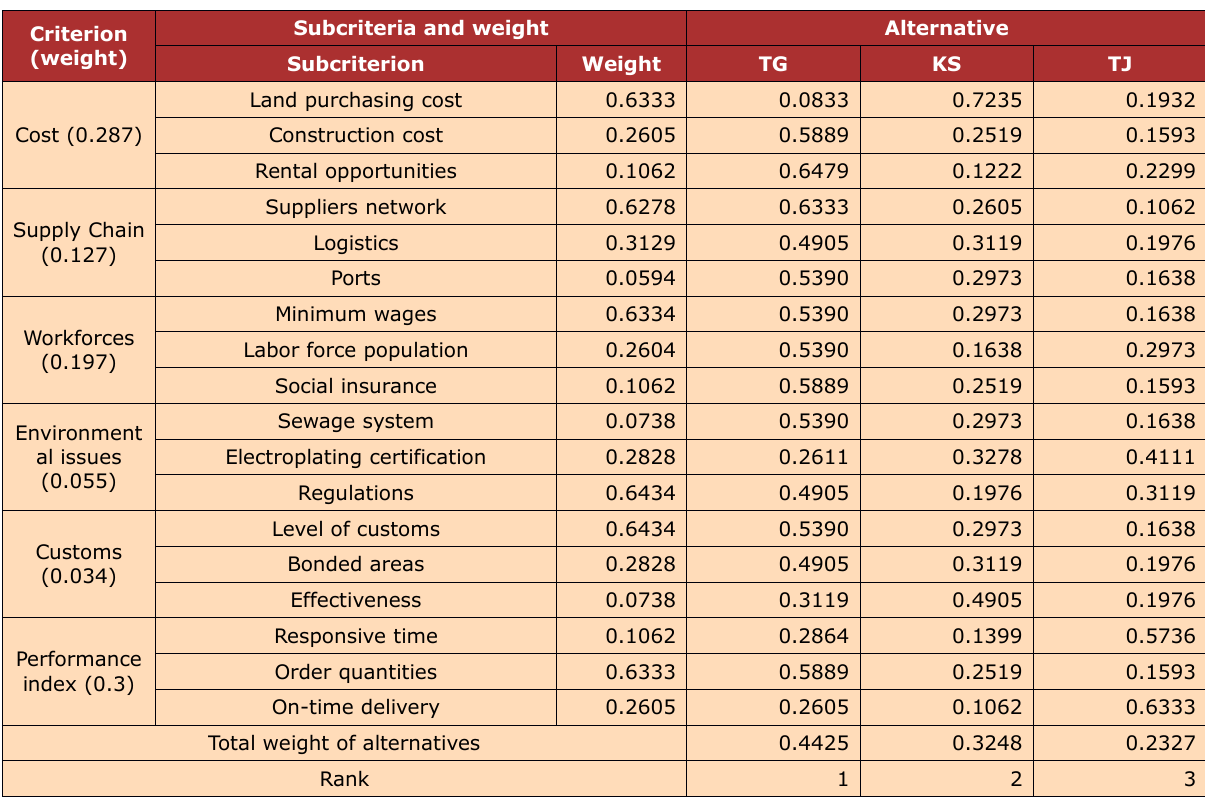
Table 7. Rank of the alternatives